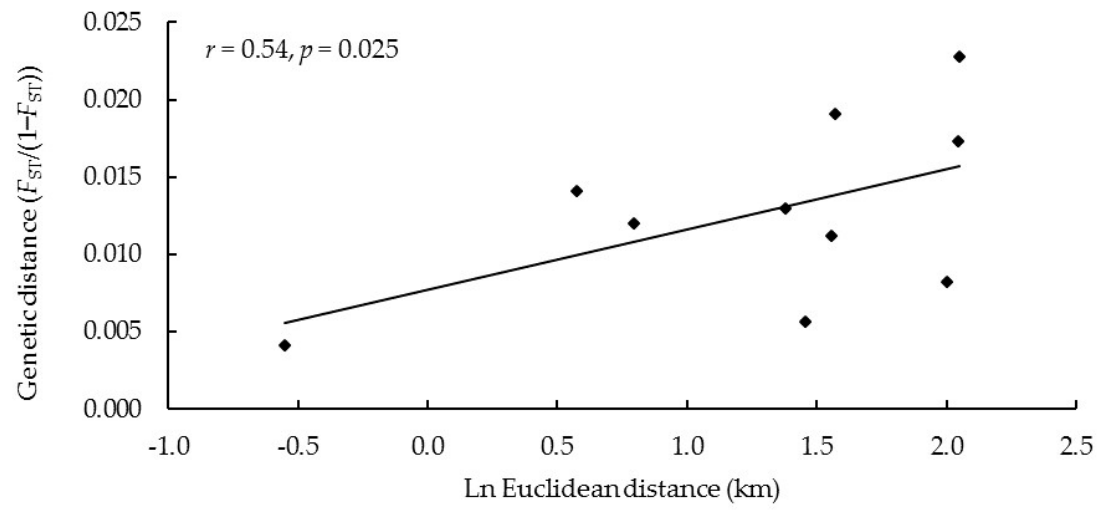
Figure 6. Mantel test of Euclidean distance and genetic distance between different red deer groups